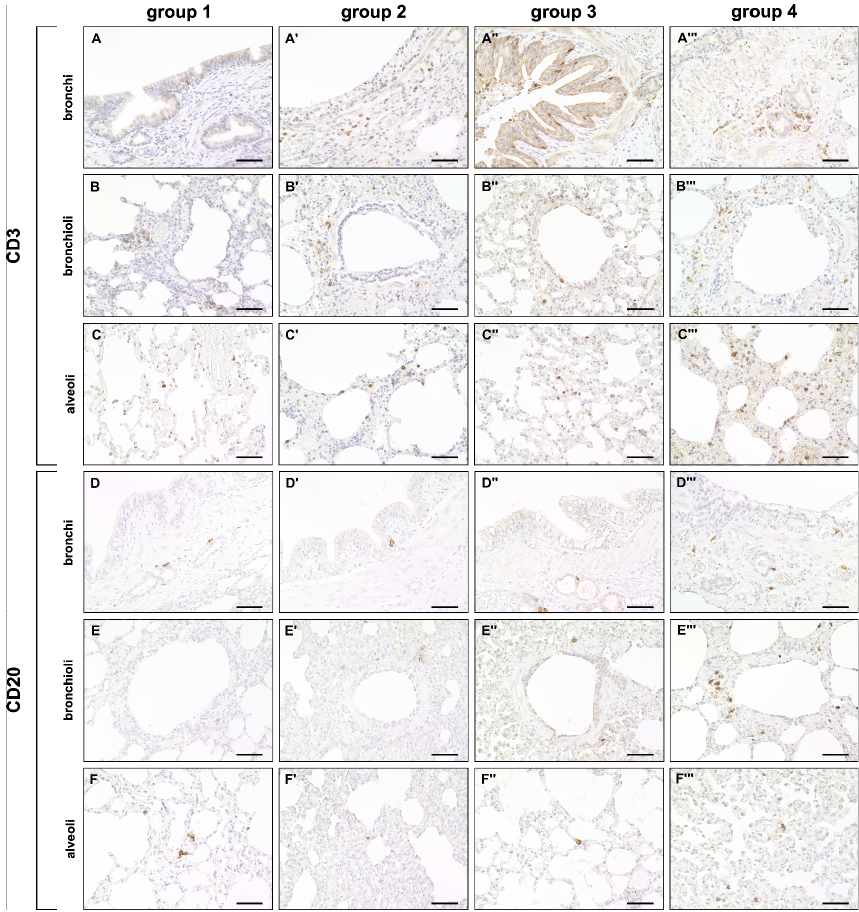
Figure 5. Adaptive cellular immune responses in canine distemper virus (CDV)-infected lungs. ( A – C’’’ ) CD3 + cell (T cell) detection in the bronchial ( A – A’’’ ), bronchiolar ( B – B’’’ ) and alveolar region ( C – C’’’ ). ( D – F’’’ ) CD20 + cell (B cell) detection in the bronchial ( D – D’’’ ), bronchiolar ( E – E’’’ ) and alveolar region ( F – F’’’ ). Groups: 1 = non-infected control lung; 2 = acute CDV infection; 3 = subacute CDV infection; 4 = subacute-chronic CDV infection. Scale bars: 50 µm.